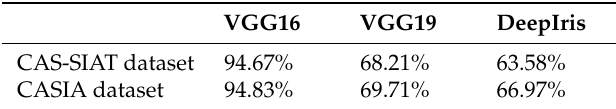
Table 7. Comparison of classification accuracy for different CNN architectures. The training and test of these networks were performed with the same dataset (cross datasets were not